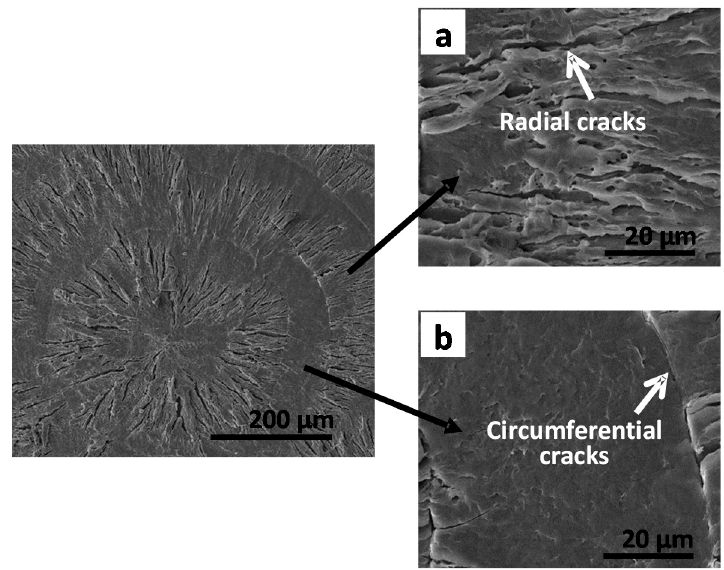
Figure 5. SEM graphs of LM w -PLLA-11k isothermally crystallized at 125 °C with a top cover (constrained) showing: ( a ) band with radial cracks; and ( b ) band with twin circumferential cracks in spherulites of PLLA isothermally crystallized at 125 °C and etched with p-dioxane. Reproduced from Ref. [29] with permission from Springer.